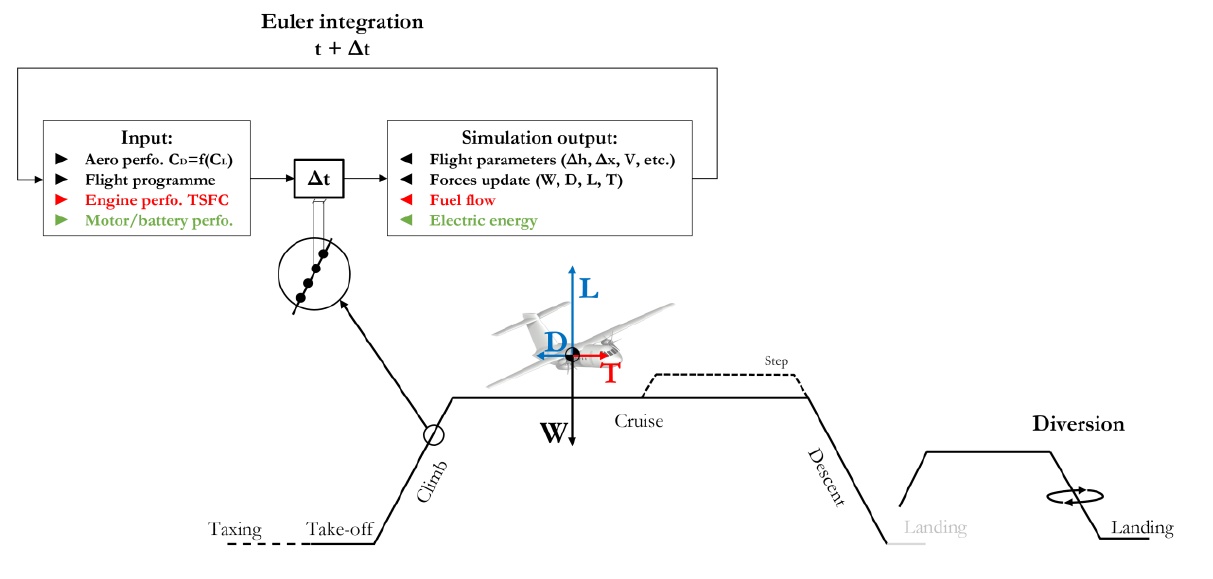
Figure 5. Scheme of the aircraft mission simulation.